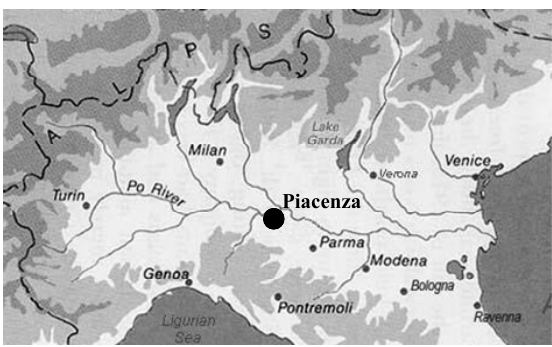
Figure 1. Location of Piacenza in the Po valley.